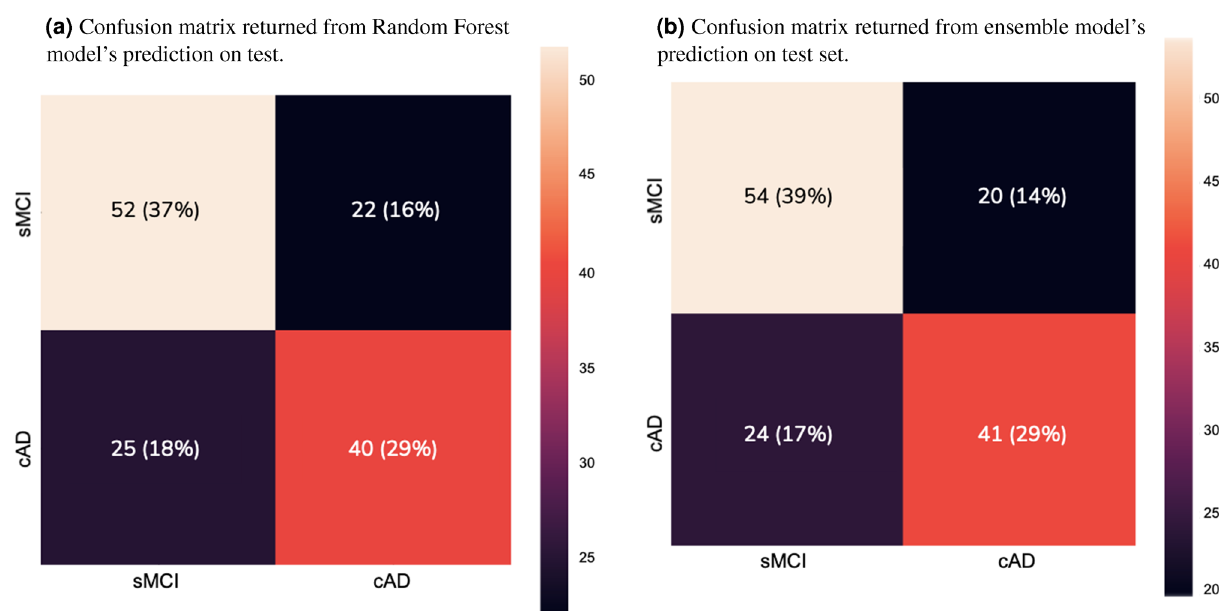
Figure 1. 2 × 2 confusion matrices computed for the sMCI and cAD labels returned from prediction on test set compared with the co-occurrences of the observed outcome. The black and purple cells represent misclassified subjects, while the beige and red cells represent correctly classified subjects. The number of occurrences in each cell is given as number of subjects and percentage of the total test set for RF model and